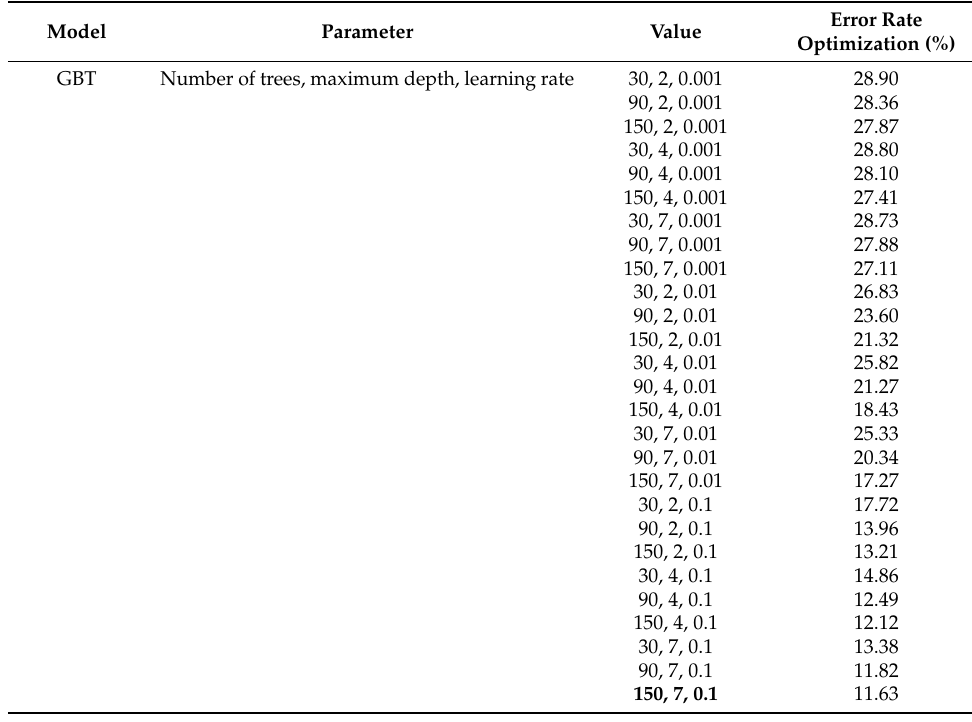
Table 6. Optimization of the GBT